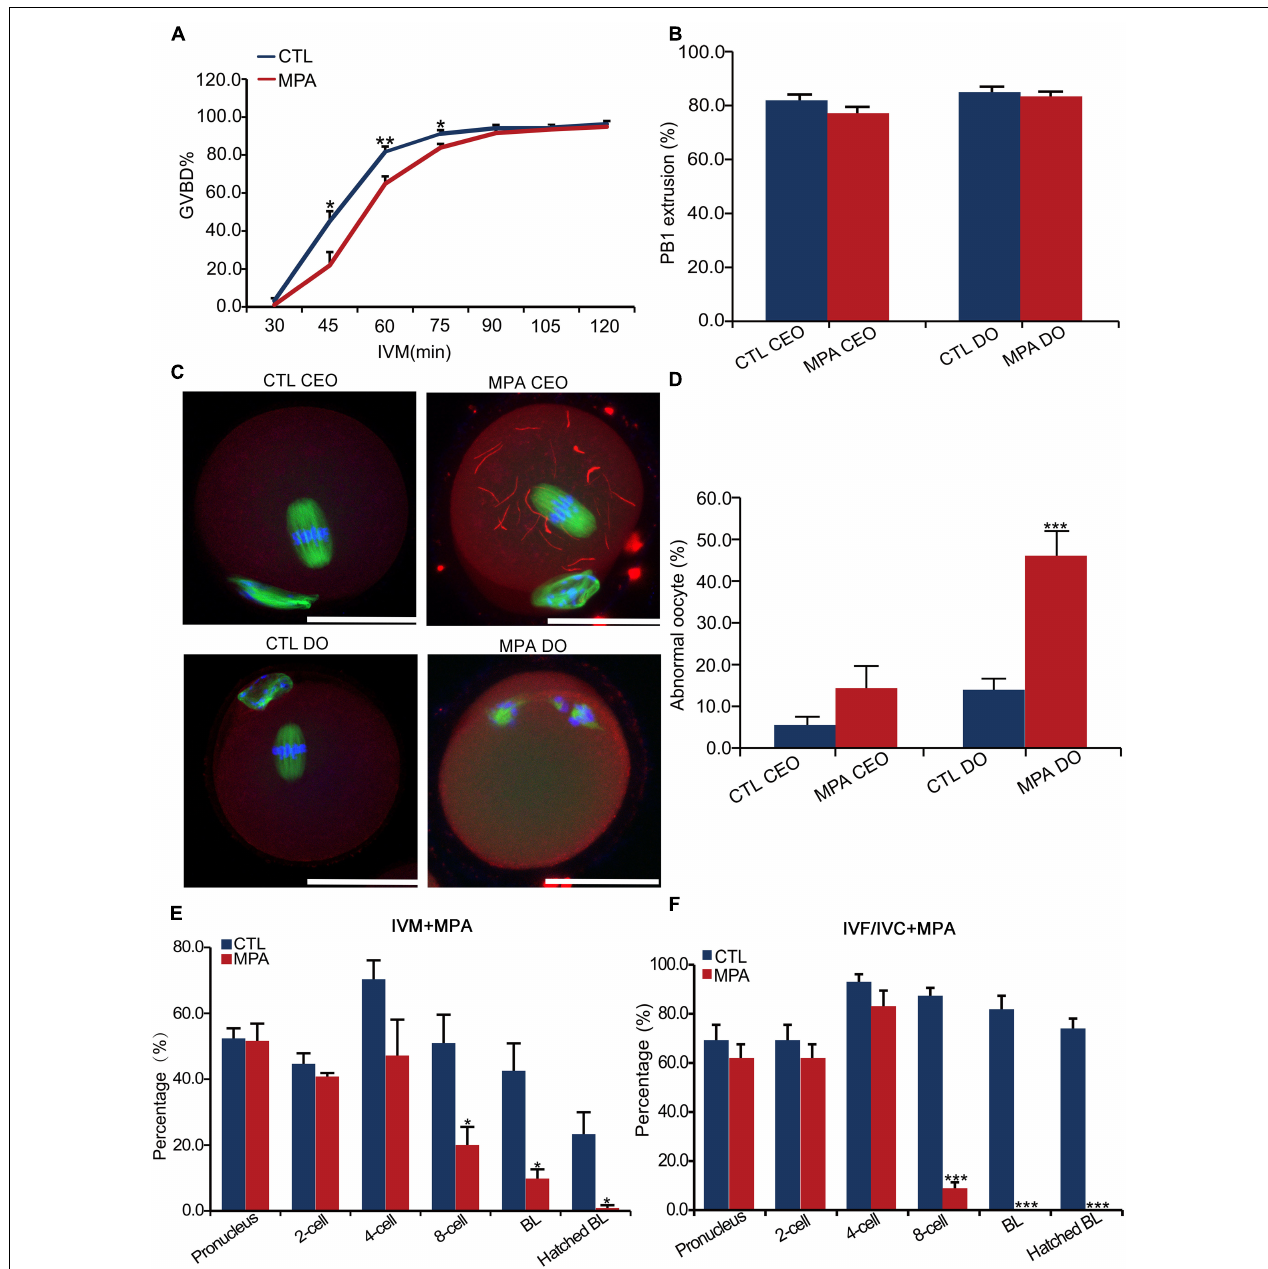
FIGURE 5 | Effects of inhibition of IMPDH activity on oocyte IMPDH2 aggregation and the development of oocyte and preimplantation embryos. (A) Effects of 100 µ M- MPA treatment on the kinetics of GVBD in DOs in vitro . * P < 0.05, ** P < 0.01, compared with the control (CTL) at the ame timepoint. (B) Effects of 100 µ M– MPA treatment on PB1 extrusion in cumulus-enclosed oocytes (CEO) and DOs in vitro . (C,D) Effects of 100 µ M- MPA treatment on IMPDH2 aggregation and the maturation into normal MII oocytes in CEO and DOs in vitro . Representative micrographs of staining of IMPDH2, α -tubulin, and chromosomes are shown in (C) , while quantification of the rate of matured oocytes with abnormal spindles and misaligned chromosomes is shown in (D) . Scale bars: 50 µ m. *** P < 0.001, compared with the CTL. (E) Effects of treating the DOs with 100 µ M- MPA during the process of maturation on the subsequent fertilization and preimplantation development. * P < 0.05, compared with the CTL at the same stage of embryos. (E) Effects of treatment with 100 µ M- MPA on the development of the preimplantation embryos. * **P < 0.001, compared with the CTL at the same stage of